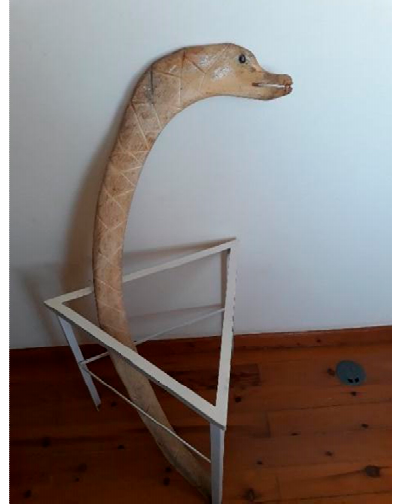
Figure 6. Ornamental carved piece of whale’s bone evoking the shape of a moray exhibited in the Museum of the Sea, Mindelo, Cape Verde. Photographed by Cristina Brito (2019).